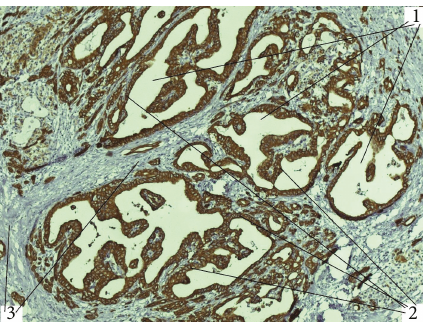
Figure 8: Experimental pancreatic cancer in the setting of SO, IHC reaction with antibodies against cytokeratin-19 receptors, magni fi cation 100x (1: cyst component; 2: papillary component; 3: tumour stroma).